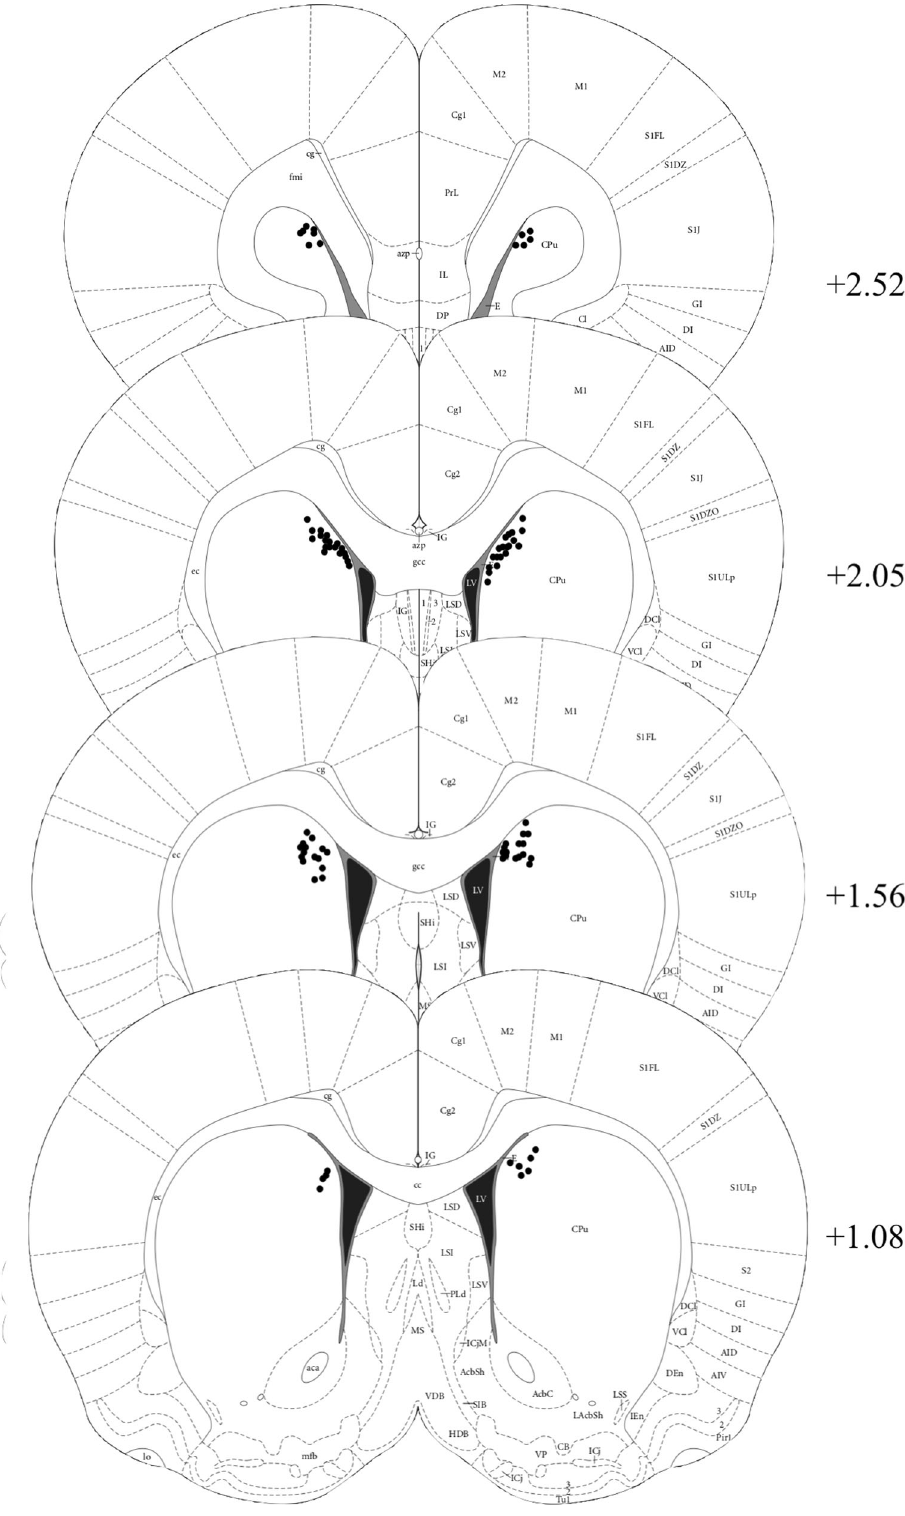
Fig. 3 Schematic representation of cannula placements in the DMS for animals included in the behavioural analyses. Templates adapted from Paxinos & Watson, 2005. Numbers indicate distance from Bregma (mm) in the anterior-posterior plane. N = 29 for the Chow and 24 for the SCM groups,